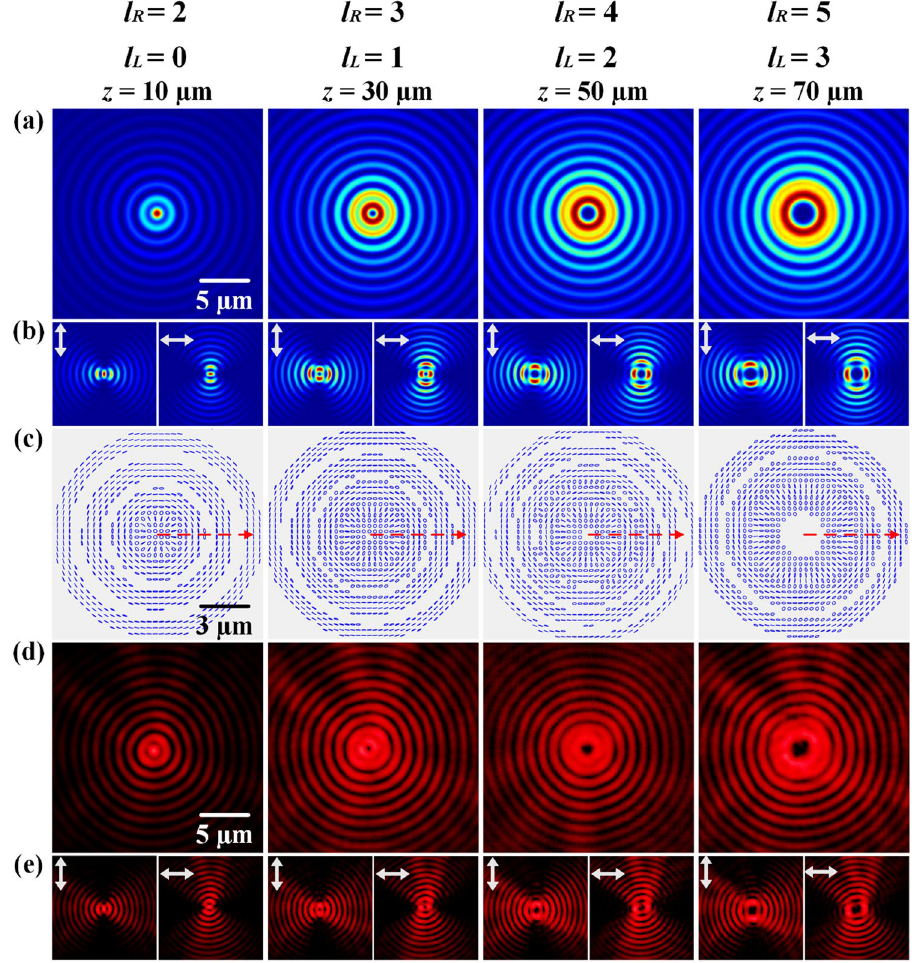
Figure 4. The second category of vector vortex beam with the variation of OAM value in the sequence of n = (1 → 2 → 3 → 4) with m = 1. ( a ) Simulated beam intensity distributions without polarization analyzer at different propagation distances. ( b ) The corresponding intensity distributions analyzed with vertical or horizontal linear polarizer. ( c ) Simulated polarization distributions. ( d , e ) Measured beam intensity